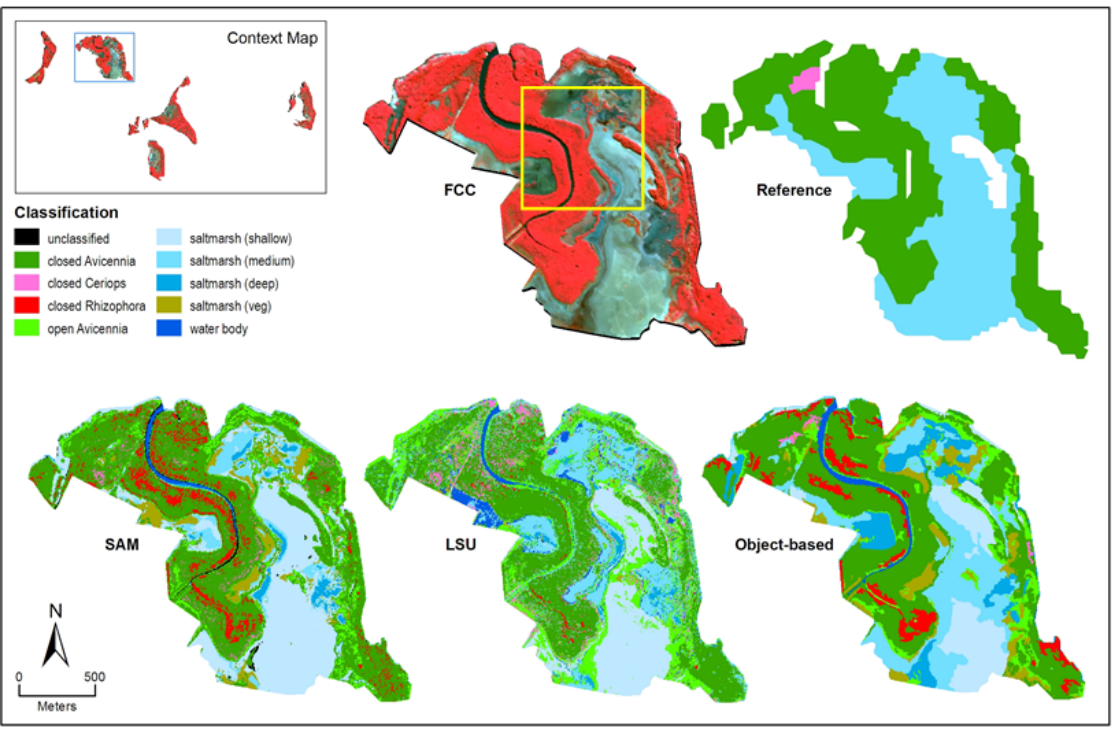
Figure 7. Classification results comparison for one of the selected areas in the study